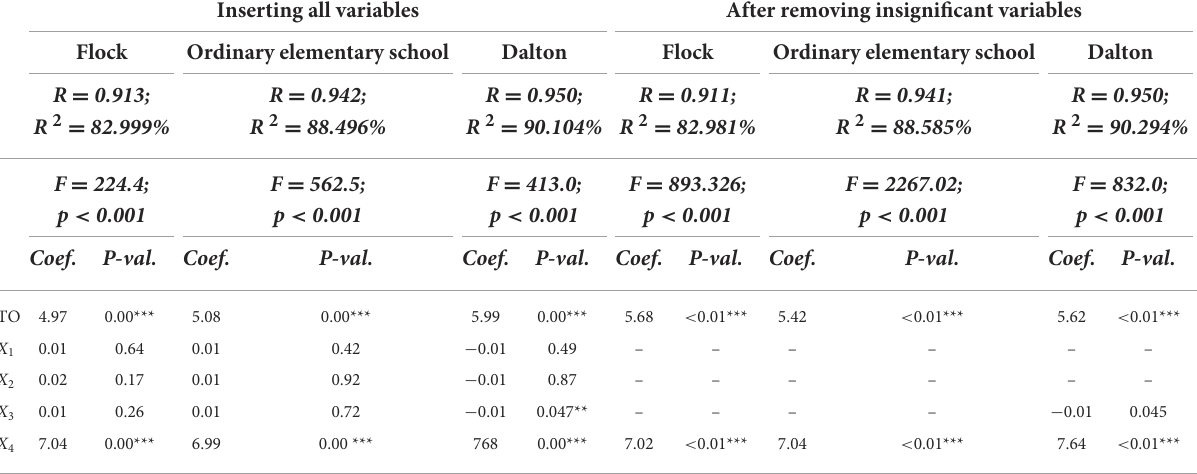
Items of the lower cognitive intensity Inserting all variables After removing insignificant variables Flock Ordinary elementary school Dalton Flock Ordinary elementary school